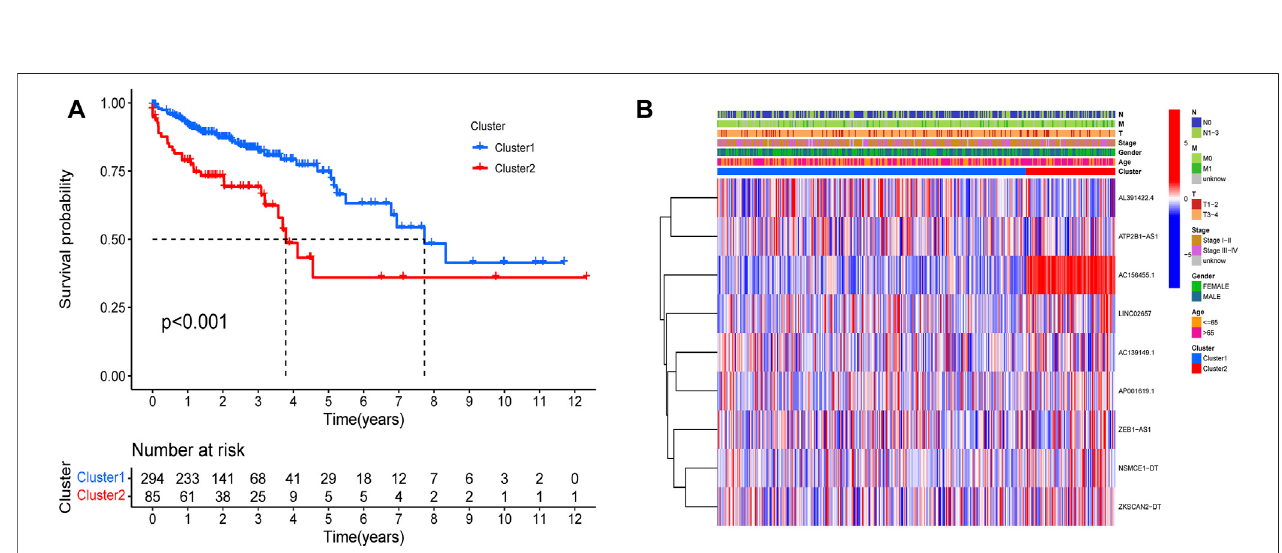
FIGURE 7 | Kaplan-Meier curves of OS for two clusters in COAD. Relationships between lncRNAs of clusters and clinical features. (A) Survival analysis of the lncRNAs in two clusters. The survival rate of type 2 was obviously low ( p < 0.001). (B) Heatmap of the two clusters along with clinicopathological characteristics. AC156455.1 expression was signi fi cantly higher in type 2.